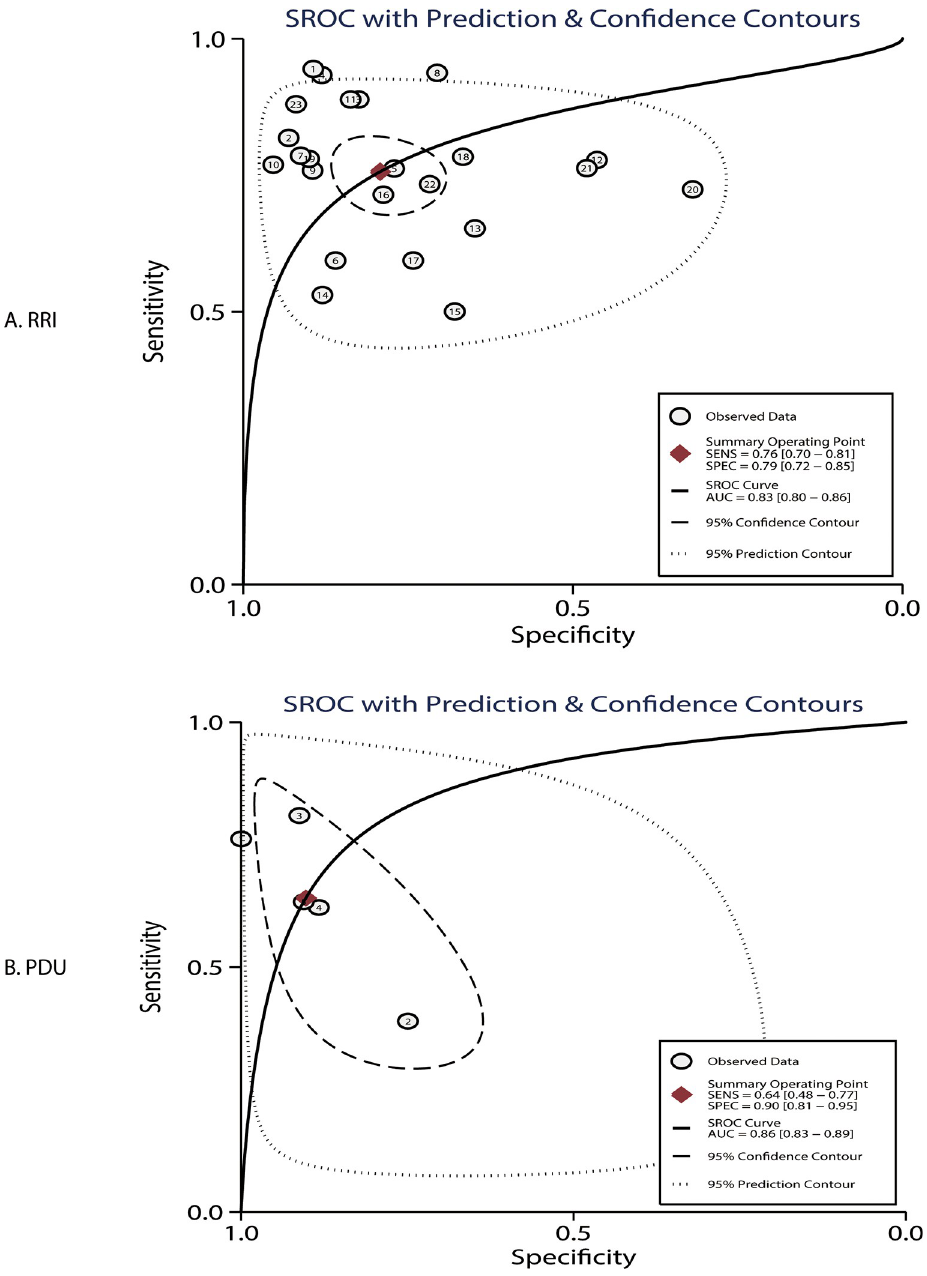
Fig 2. Summary of the AUC of the RRI and PDU for predicting